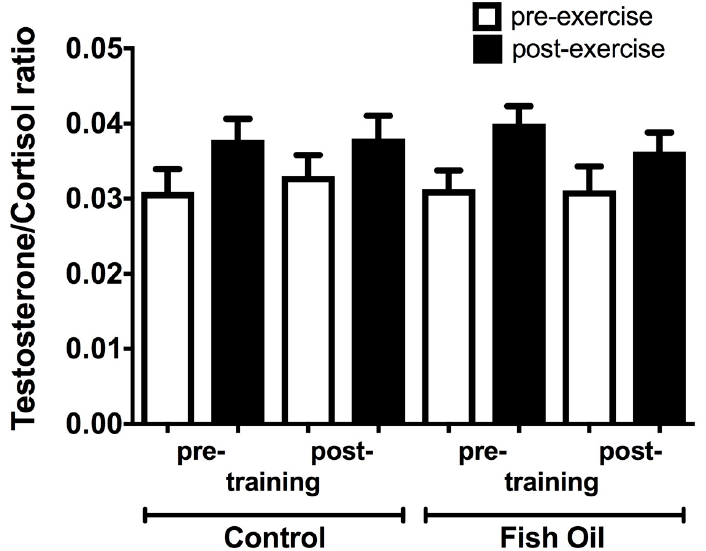
Figure 3. Effect of fish supplementation on plasma testosterone:cortisol ratio in response to a single bout of strength exercise before (pre-training) and after (post-training) 6 weeks of daily undulating strength training. Results presented as mean ± S.E.M.